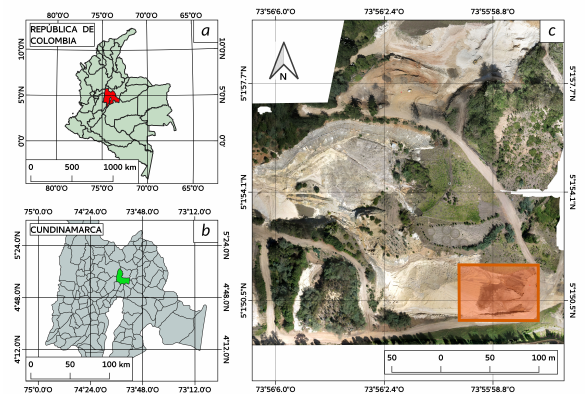
Figure 1. Location of study area, a quarry zone in Zipaquira, Cundinamarca (Colombia): (a) Colombia’s departments (light green colour), Cundinamarca (red colour); (b) Cundinamarca’s municipalities (light grey colour), Zipaquira municipality (green colour); (c) Deposit zone No. 5 is highlighted in orange colour. a hexacopter Tarot 680PRO Figure 2a, with a low cost cam- pixel. The time of each flight was approximately 8 minutes.